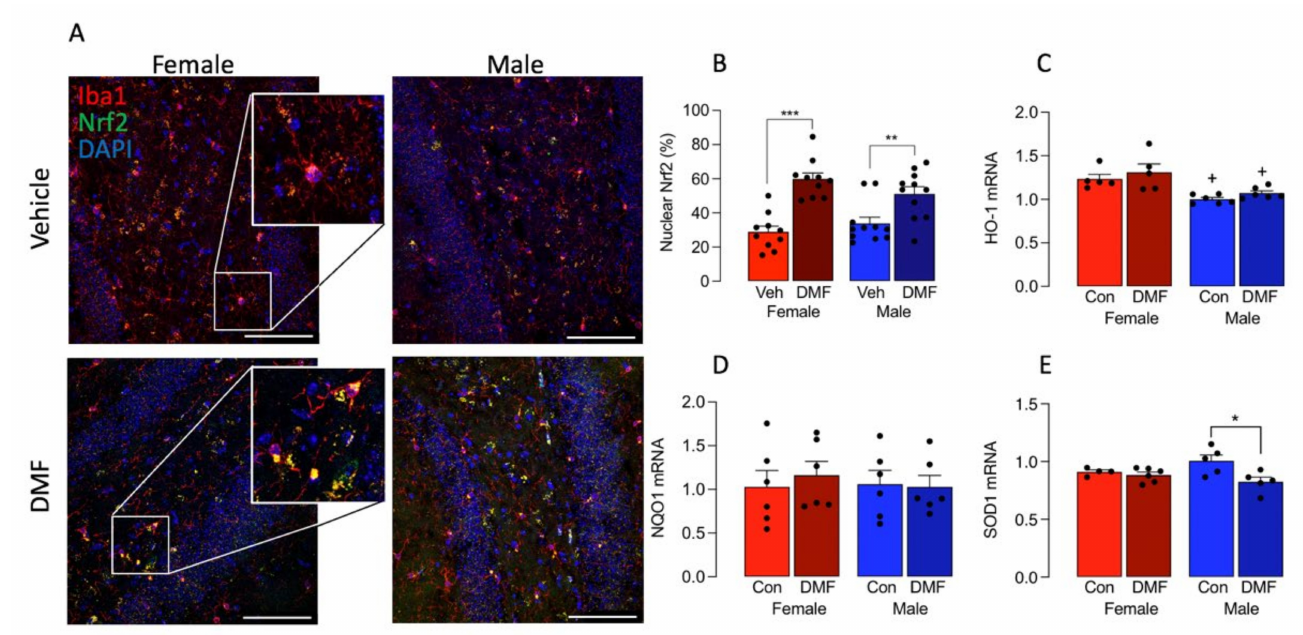
Figure 5. DMF increases the translocation of Nrf2 to the nucleus in Iba1 + microglia in hippocam- pus. ( A , B ). Nrf2 expression in DAPI-stained nuclei was assessed in Iba1 + microglia in hippocampal sections prepared from DMF- and vehicle-treated control male and female mice. The sample immuno- graphs and insets indicate that DMF increased Nrf2 staining with a significant main effect of treatment ( p < 0.001; 2-way ANOVA) and the higher magnification insets show decreased co-localization of Nrf2 in DAPI-stained nuclei in control compared with DMF-treated samples from female mice. Post hoc analysis indicated that DMF significantly increased Nrf2 + DAPI + staining in Iba1 + cells from female and male mice compared with their respective vehicle-treated controls (** p < 0.01; *** p < 0.001). Data from 2 experiments are expressed as a percentage of the total number of Iba1 + microglia and are presented as means ± SEM ( n = 10 or 11). Scale bar = 50 µ m. ( C ) A significant main effect of sex was observed in HO-1 mRNA ( p < 0.001) and expression was significantly reduced in the hippocampal tissue from vehicle-treated males compared with vehicle-treated females ( + p < 0.05) and from DMF- treated males compared with DMF-treated females ( + p < 0.05). ( D ) DMF exerted no significant